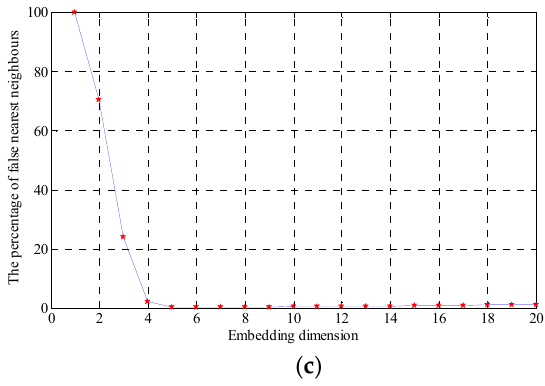
Figure 19. Roller fault ( a ) time domain waveform, ( b ) envelope spectrum ( c ) Embedded dimension. As shown in the Figure 19, the embedding dimension number is optimal at 5. Trajectory matrix reconstruction and SVD are performed with embedding dimension number of 5. The SVs obtained are as shown in Figure 20.